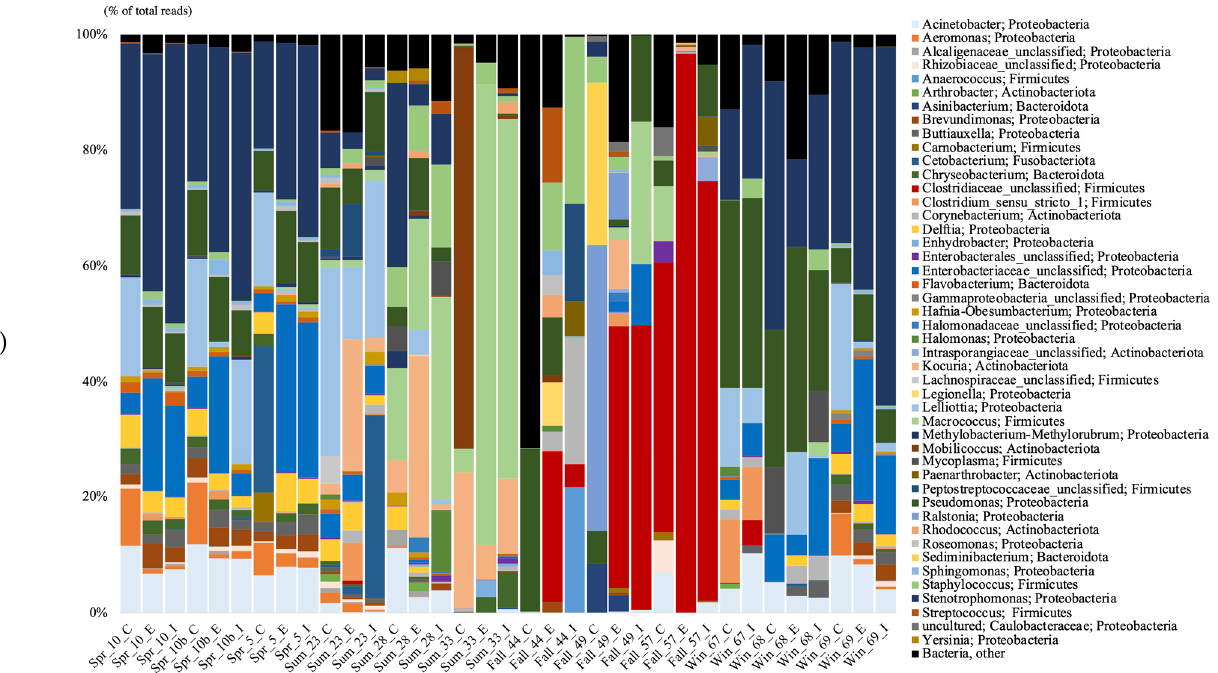
Figure 1. Bacterial 16S rRNA gene taxonomic affiliations at the phylum ( a ) and genus ( b ) levels. S, stomach; C, cecum; I, intestine; Spr, spring; Sum, summer; Win, winter.